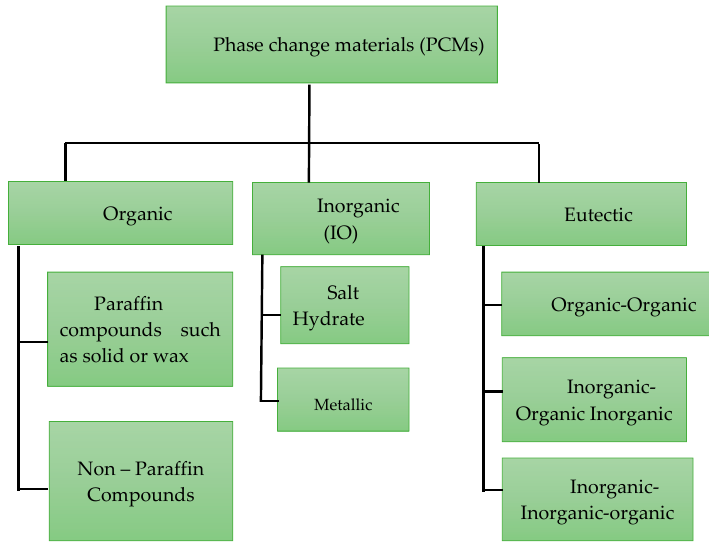
Figure 1. Classification of phase-change materials (PCMs) [4]. Figure is reprinted with permission from publisher. Table 1. Synopsis of the investigations about different nano-paraffin composites.